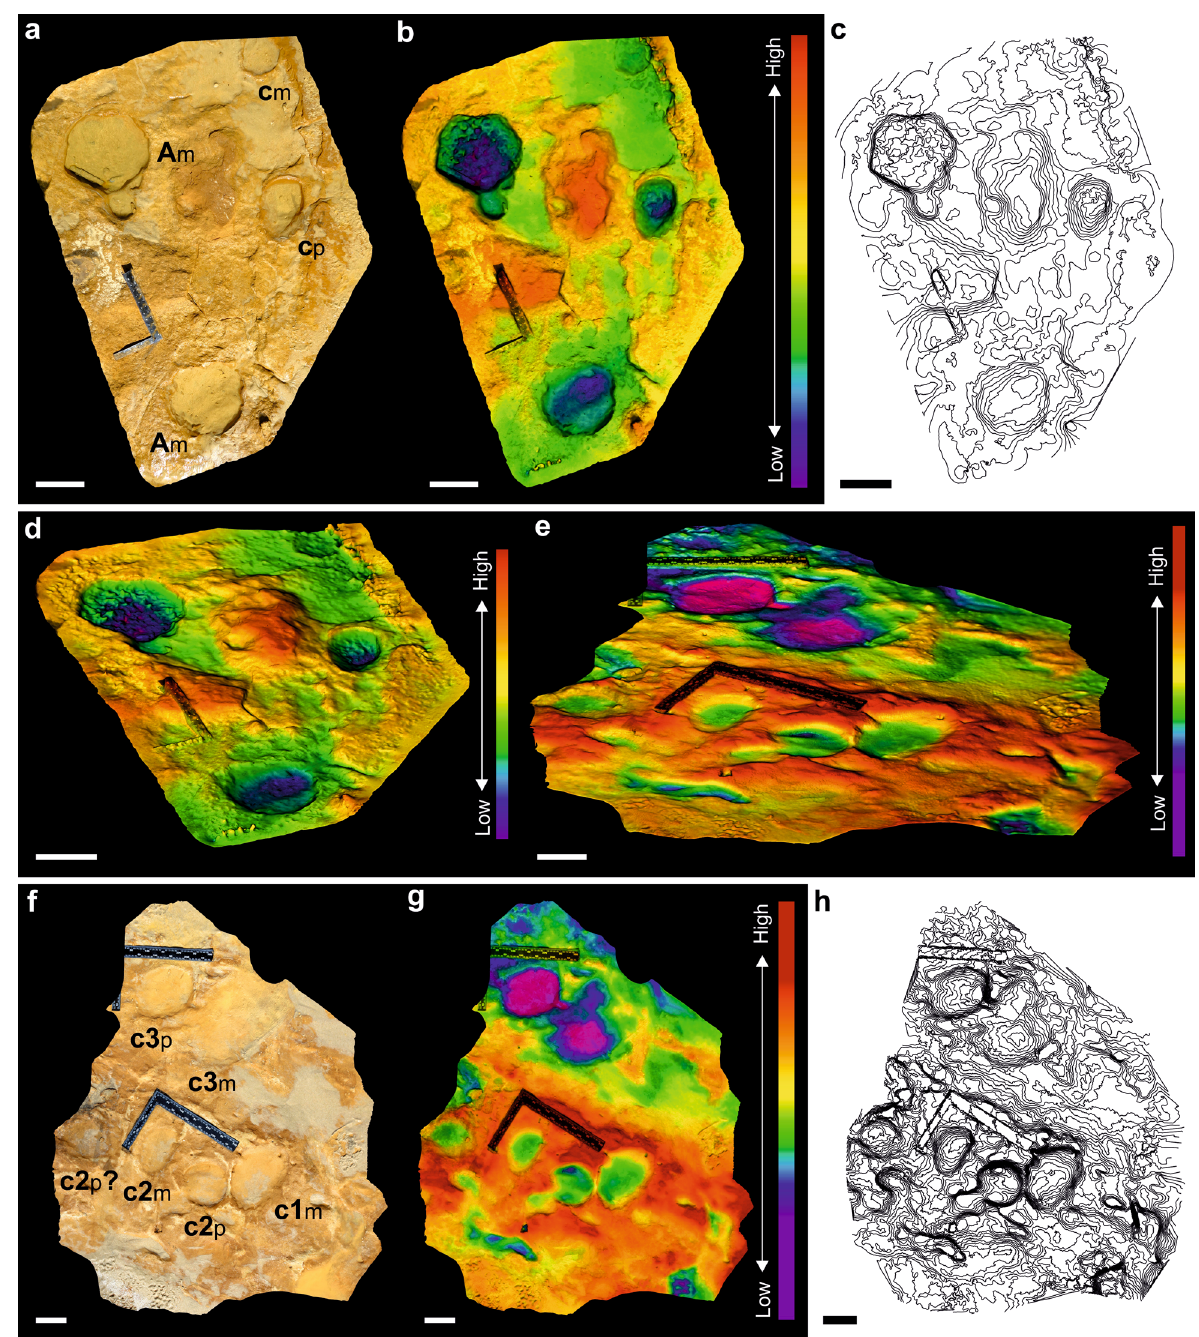
Figure 6. Examples of adult (presumably female)-calf trackways (PAT/MTS/015: for measurements of tracks and estimations of body mass and age see Table 1). ( a ) Real-image of two parallel trackways showing the same direction of movement indicated by the presence of drag marks in the calf trackway and the deepest part of the track always located in the same size of both trackways (interpreted as the anterior one) as shown in the vertical ( b ) and oblique ( d ) depth maps and the contour maps ( c ). Scale bar = 20 cm. ( e – h ) PAT/MTS/008: Tracks of young elephants produced contemporarily except the two larger ones which are deeper imprinted (scale bar = 10